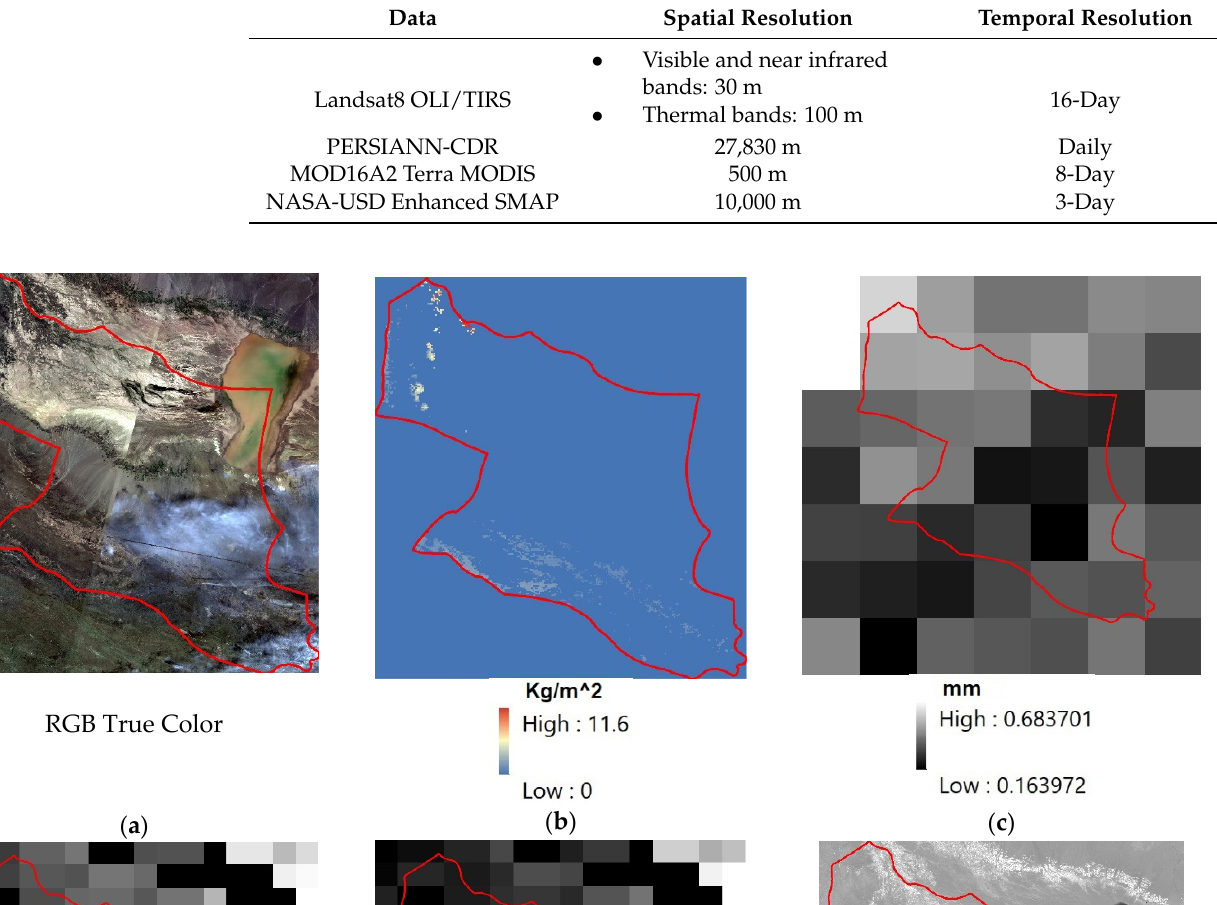
Table 1. Specifications of the data used.